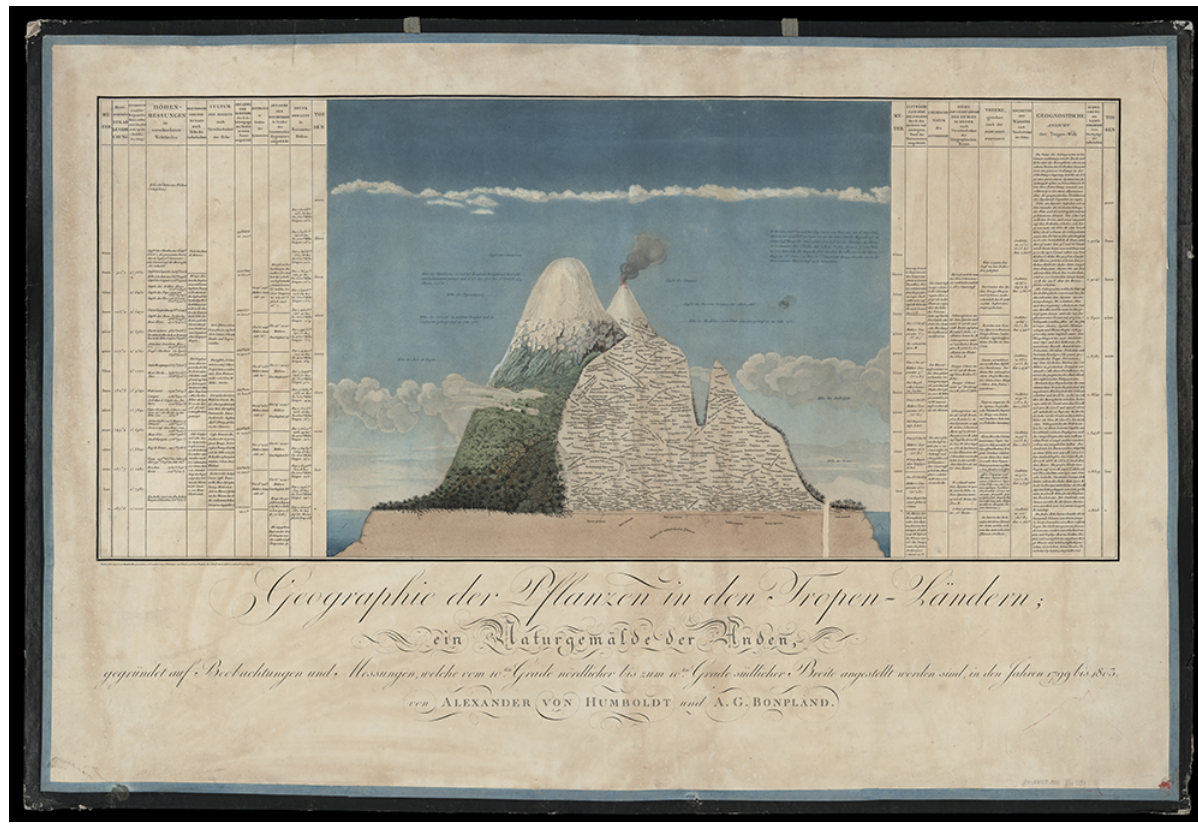
Figure 2 e Chimborazo Mt with the original notes of Alexander von Humboldt depicting the patterns of vegetation and highlighting both the dominant species in plant communities and environmental data (from Ideen zu einer Geographie der Pflanzen nebst einem Naturgemälde der Tropenländer by von Humboldt and Bonpland,